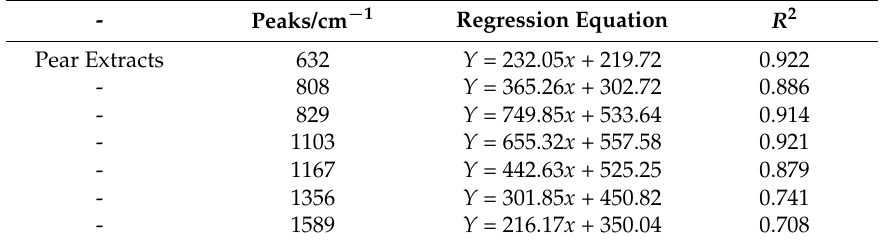
Table 3. Linear relationship between the intensities of prominent characteristic peaks and the different concentrations of flusilazole in the SERS spectra of pears extracts.